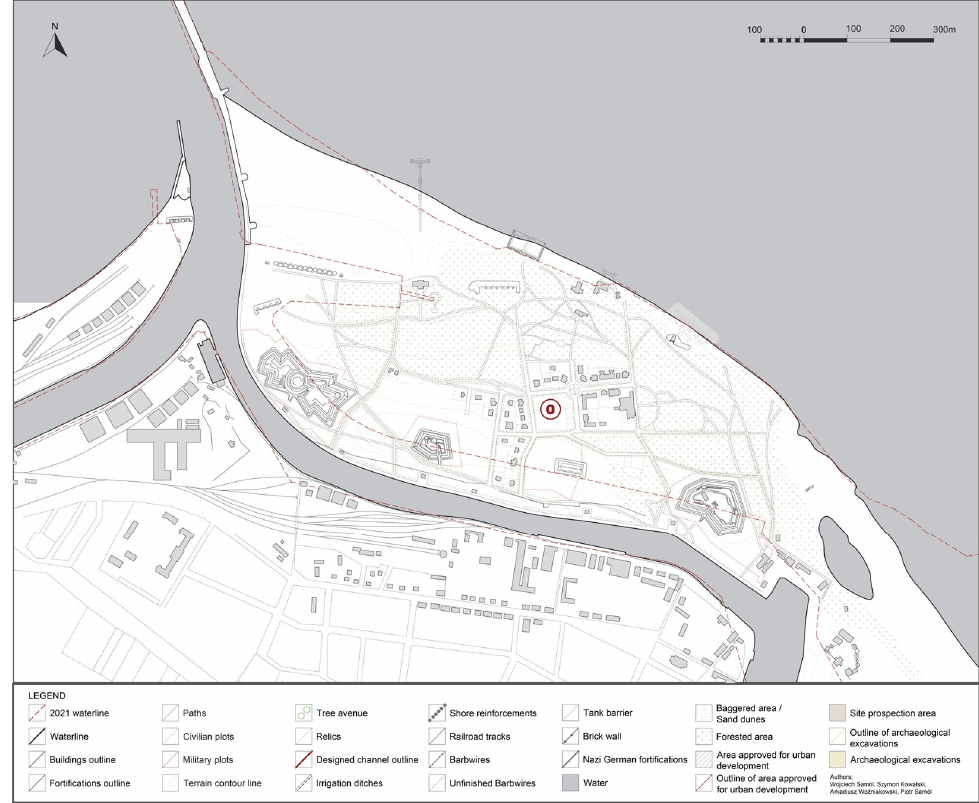
Figure 9. Westerplatte during the First World War